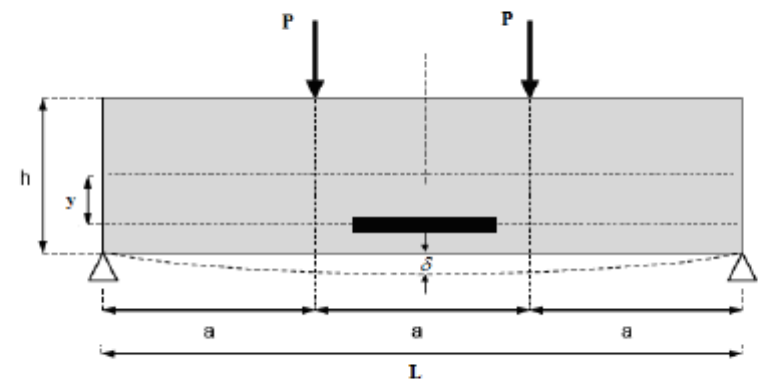
Figure 15. Test of asphalt concrete beam.